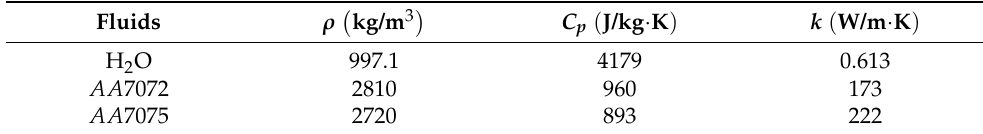
Table 1. The base fluids’ and nanoparticles’ material properties.